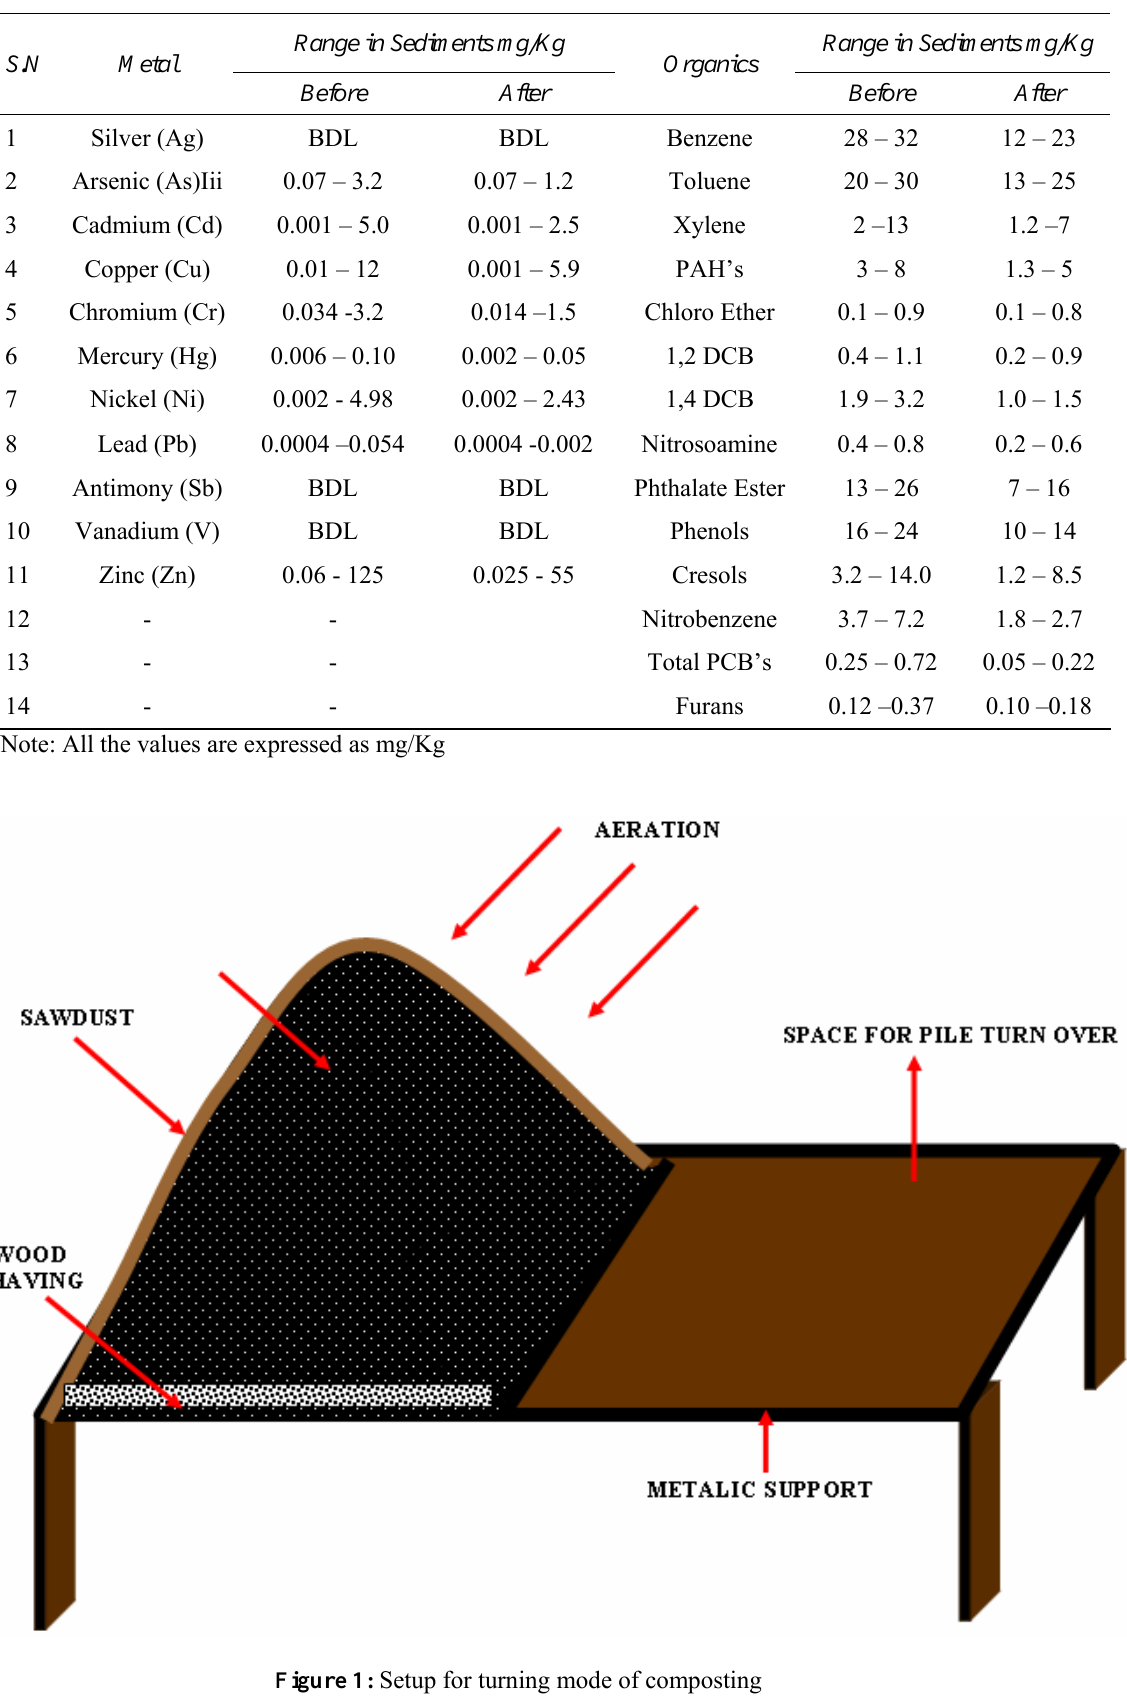
Table 1: Heavy metal and organics concentrations before and after composting S.N